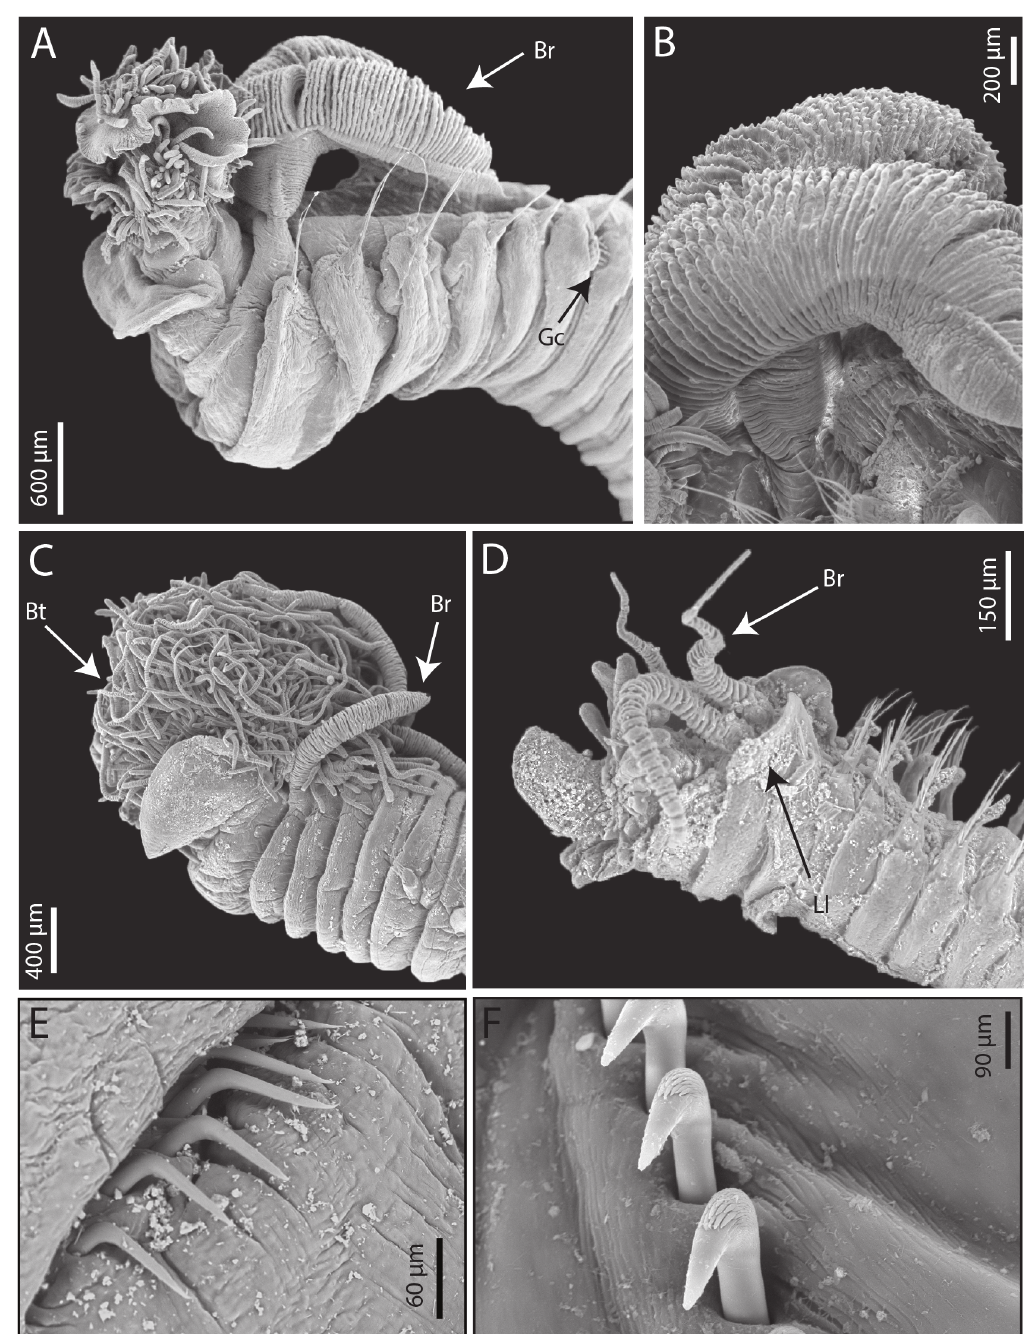
Fig. 8. Diversity of Trichobranchidae, SEM. A . Terebellides gentili Lavesque, Hutchings, Daffe, Nygren & Londoño-Mesa, 2019, anterior end, lateral view (MNHN-IA-TYPE 1873). B . Terebellides lilasae Lavesque, Hutchings, Daffe, Nygren & Londoño-Mesa, 2019, branchia, lateral view (MNHN- IA-TYPE 1881). C . Trichobranchus glacialis Malmgren, 1866, anterior end, lateral view (SMA-BR- Tricho-05). D . Octobranchus lingulatus (Grube, 1863), anterior end, lateral view (MNHN-IA-PNT 94). E . Terebellides resomari Lavesque, Hutchings, Daffe, Nygren & Londoño-Mesa, 2019, geniculate chaetae (paratype MNHN-IA-TYPE 1892). F . Terebellides lilasae , thoracic uncini (SMA-ARC- Terebellides-VOG8-1). Abbreviations: Br = Branchiae; Bt = Buccal tentacles; Gc = Geniculate chaetae; Ll = Lateral